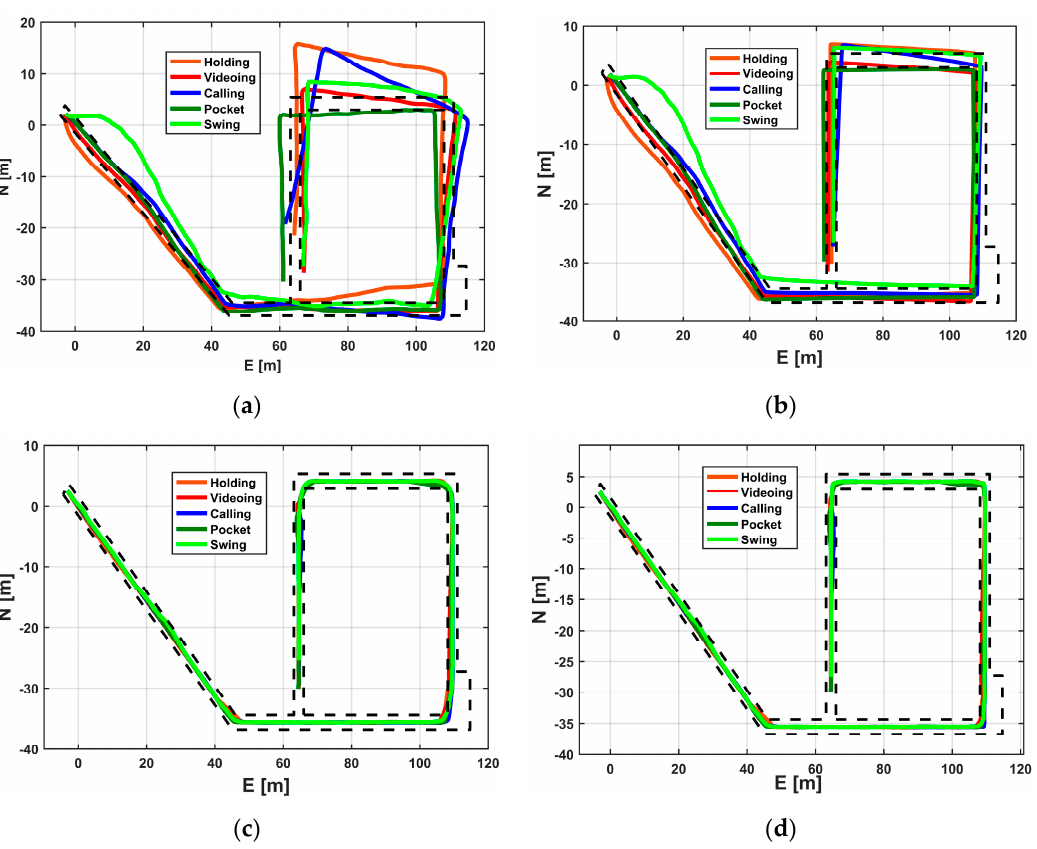
Figure 13. Comparison of the trajectories of different methods in five modes. The black dotted box represents the corridor distribution of the test site; ( a ) the trajectory calculated by step-wise heading; ( b ) the trajectory calculated by global heading; ( c ) the trajectory calculated by fusion heading; ( d ) the trajectory corrected by behavior landmark. Table 5. Mean and maximum comparison of the position errors for different heading estimation methods in five modes.